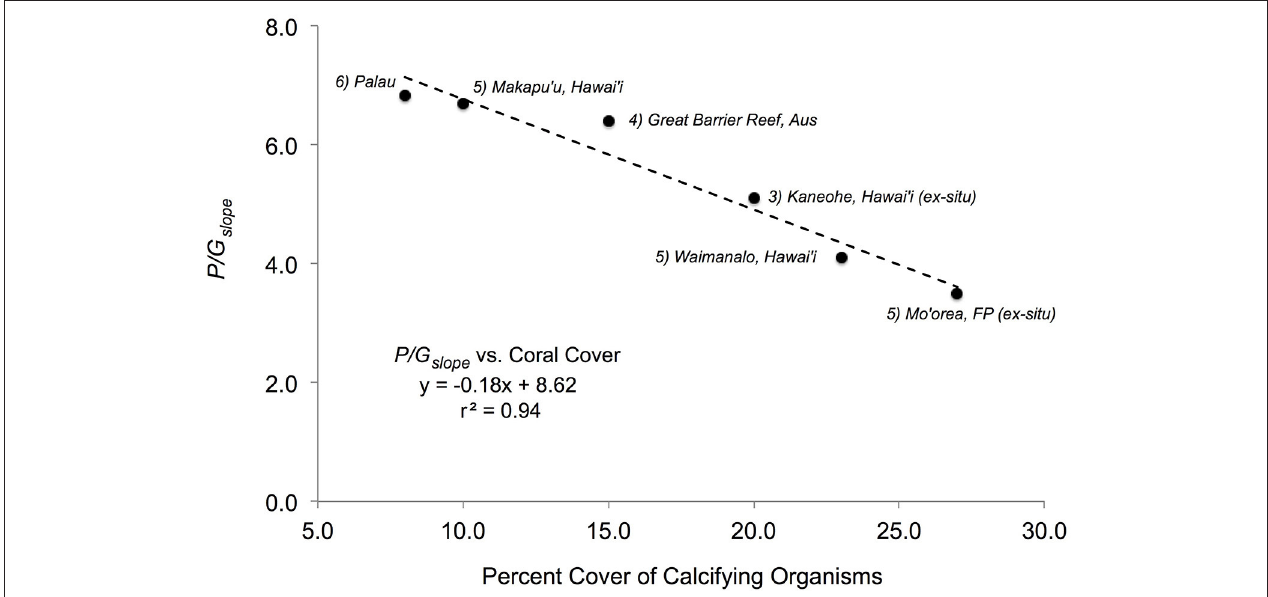
FIGURE 5 | P/G slope values from different studies (which have measured net P and net G together with percent coral cover on natural reef flat communities) as a function of percent cover of calcifying organisms for each study. (1) Present study with a P/G slope = 3.52 and 27% coral cover; (2) a natural reef community in Waimanalo (Oahu), Hawai’i, with a P/G slope = 4.1 and 23% coral cover (Lantz et al., 2014); (3) an experimental reef community in Oahu, Hawai’i, with P/G slope = 5.10 and 20% coral cover (Andersson et al., 2009); (4) a natural reef community on the Great Barrier Reef with a P/G slope = 6.4 and 15% coral cover (Suzuki and Kawahata, 2003 ); (5) a natural reef community at Makapu’u (Oahu), Hawai’i, with a P/G slope = 6.7 and 10% coral cover (Lantz et al., 2014), and (6) a natural reef community in Palau with a P/G slope = 6.83 and 8% coral cover ( Watanabe et al., 2006). Slope and r 2 -value shown for the overall linear